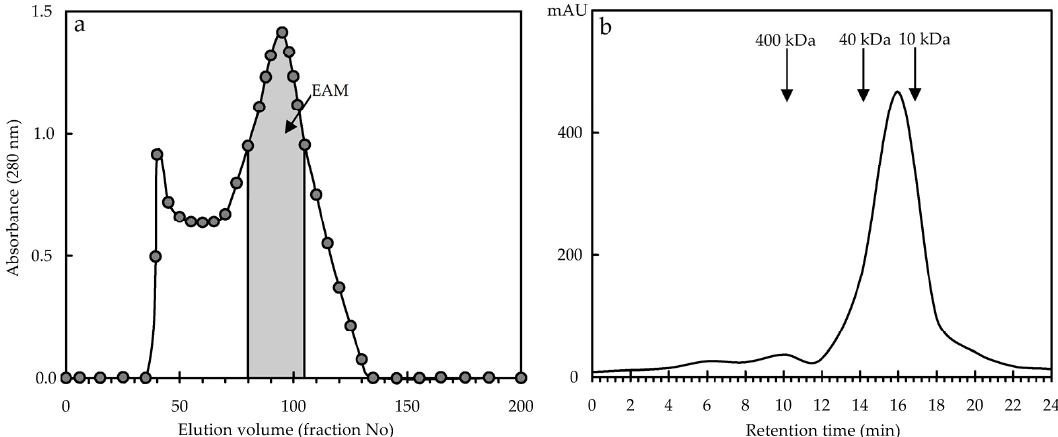
Figure 3. The elution profile of the total melanoidin fraction of E. angustifolium fermented leaves on a Sephadex G-150 column ( a ) and high-performance gel permeation chromatography with photodiode array detection (HPGPC-PDA) profile of purified melanoidin (EAM) ( b ).